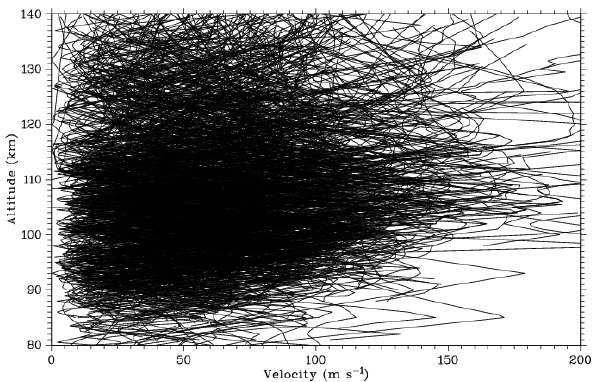
Fig. 1. Superposition of more than 500 mid- and low-latitude neu- tral wind magnitude profiles measured with the chemical release technique from sounding rockets since the late